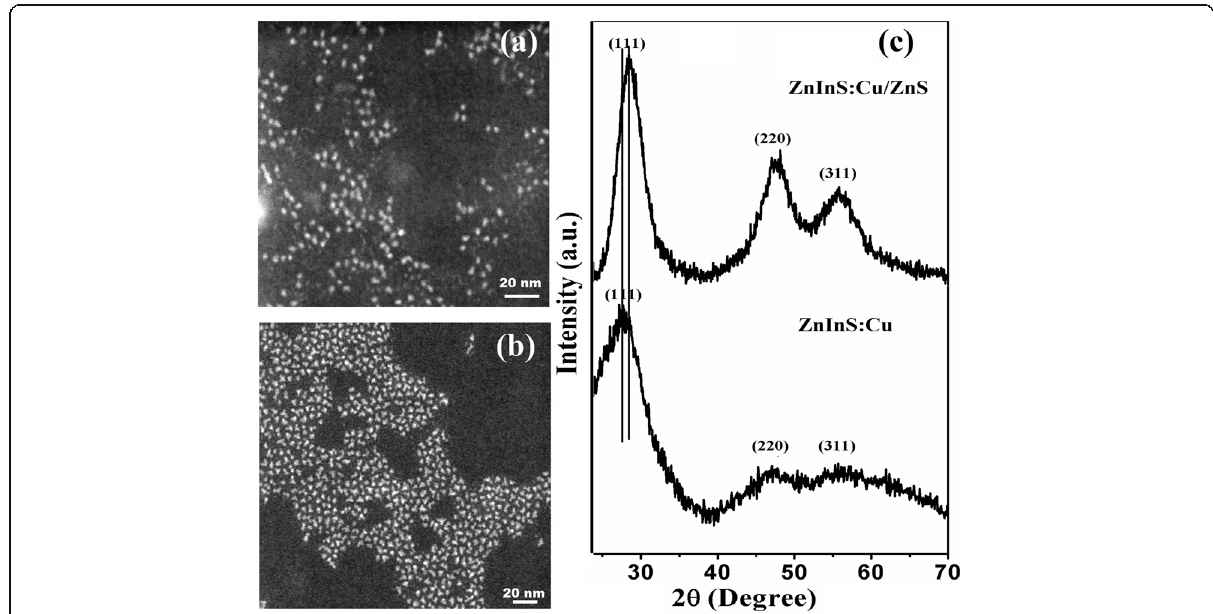
Fig. 1 Transmission electron microscopy (TEM) images of a ZnInS:Cu (core) and b ZnInS:Cu/ZnS (core/shell) CNCs. c X-ray diffraction (XRD) pattern of ZnInS:Cu (core) and ZnInS:Cu/ZnS (core/shell) CNCs